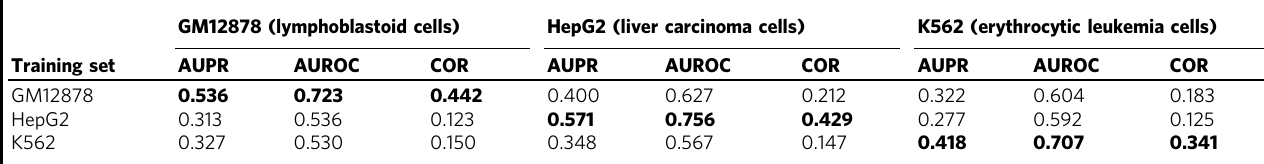
Table 1 Transferability of cell type/tissue-speci fi c predictions of regulatory variants across tissues GM12878 (lymphoblastoid cells) HepG2 (liver carcinoma cells) K562 (erythrocytic leukemia cells)